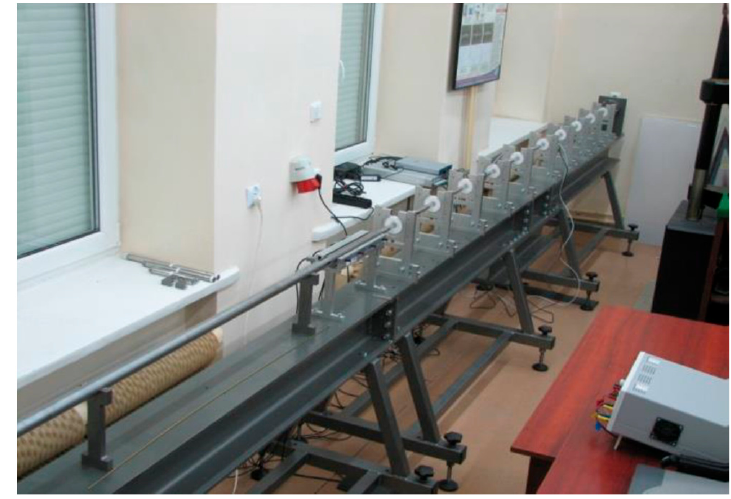
Figure 2. Station for measuring materials at high strain rates. Based on the obtained stress–strain curves, the compressive strength, stress in the plateau zone, and absorbed energy were determined. Three deformation stages can be observed on each stress–strain curve of the ceramic elastomer composites presented in Figure 3. First is the elastic stage, between 0% and approx. 5% of failure strain. Second plateau stage, which starts from approximately 5% of failure strain and ends with the densification strain. For this stage, slight stress increase together with a rapidly increased strain can be observed [33]. The last stage is the densification stage. In this study, the plateau stress σ pl was expressed as Equation (1):